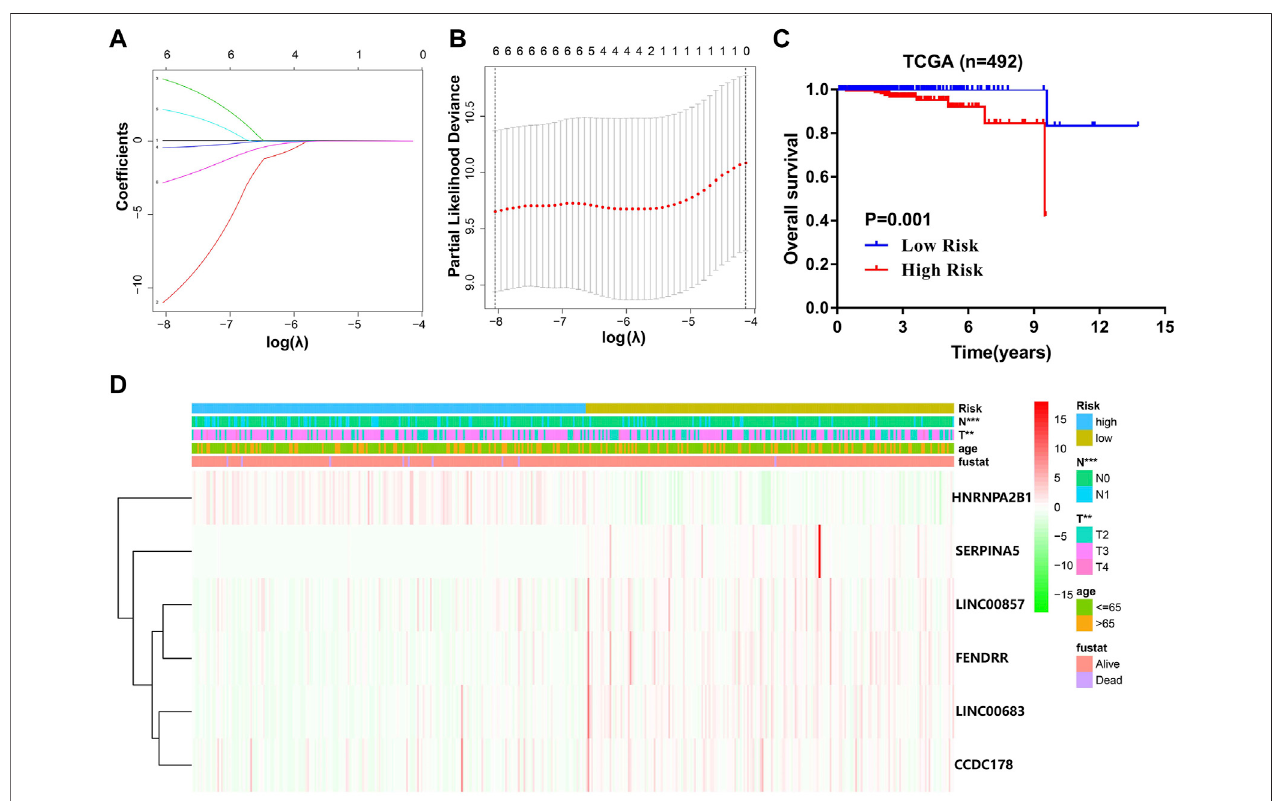
FIGURE 7 | Construction of a comprehensive diagnostic scoring model for PCa. (A,B) The process of selecting risk genes using the LASSO algorithm. (C) Kaplan – Meier analysis of PCa patients for high-risk (red) and low-risk groups (blue). (D) Heatmap of differences in the clinicopathologic features of PCa patients for low- risk and high-risk